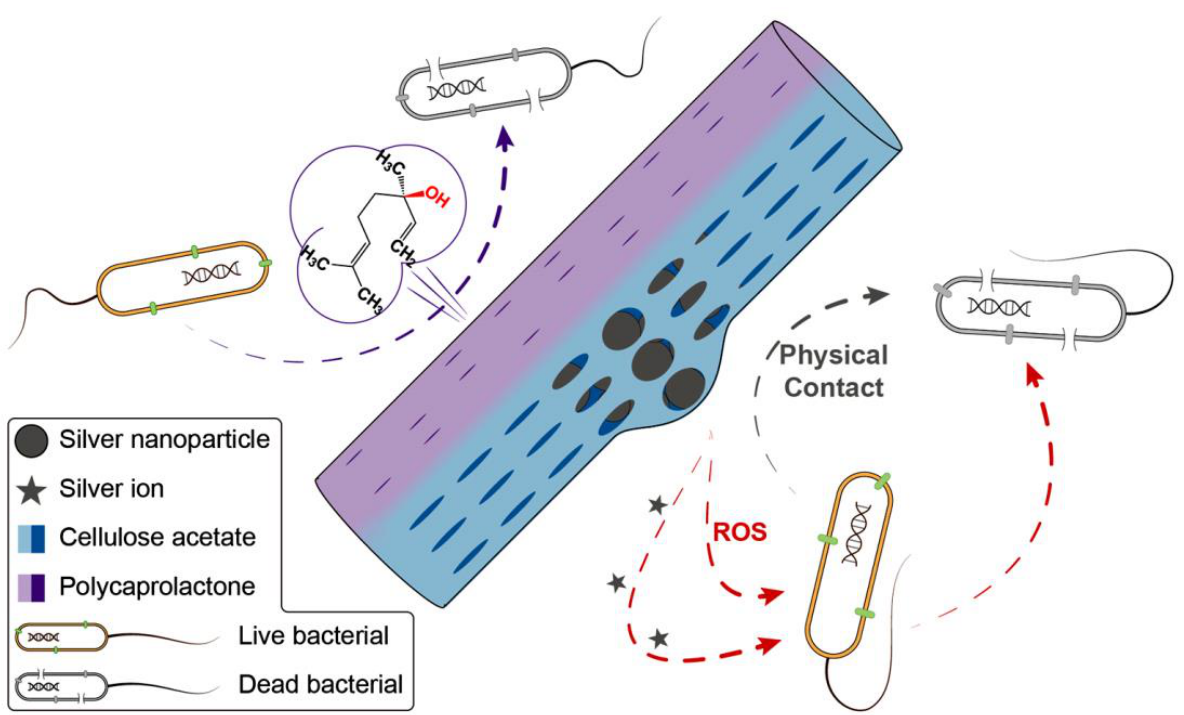
Figure 9. Antibacterial mechanism of prepared Janus nanofiber.